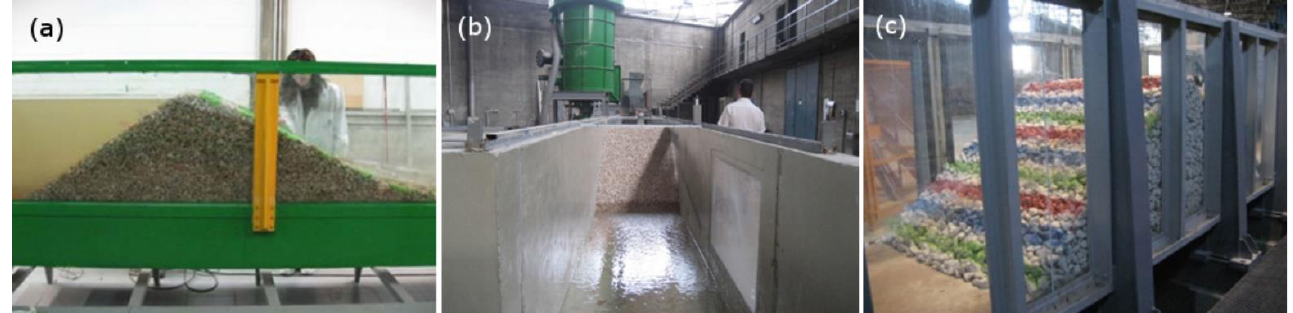
Figure 5. Some views of the three CEDEX flumes: ( a ) small, ( b ) medium, and ( c ) large.